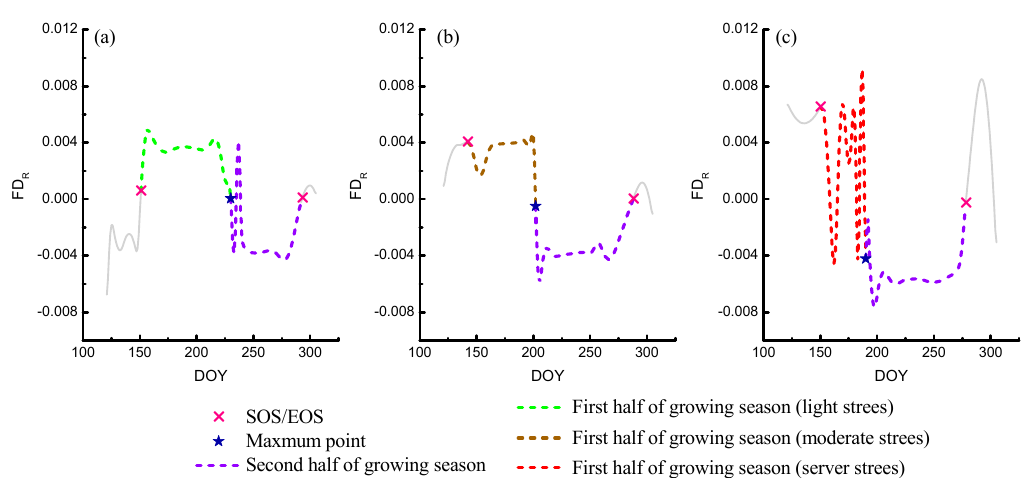
Figure 7. FD R under different levels of heavy metal stress, including light stress ( a ), moderate stress ( b ), and severe stress ( c ).